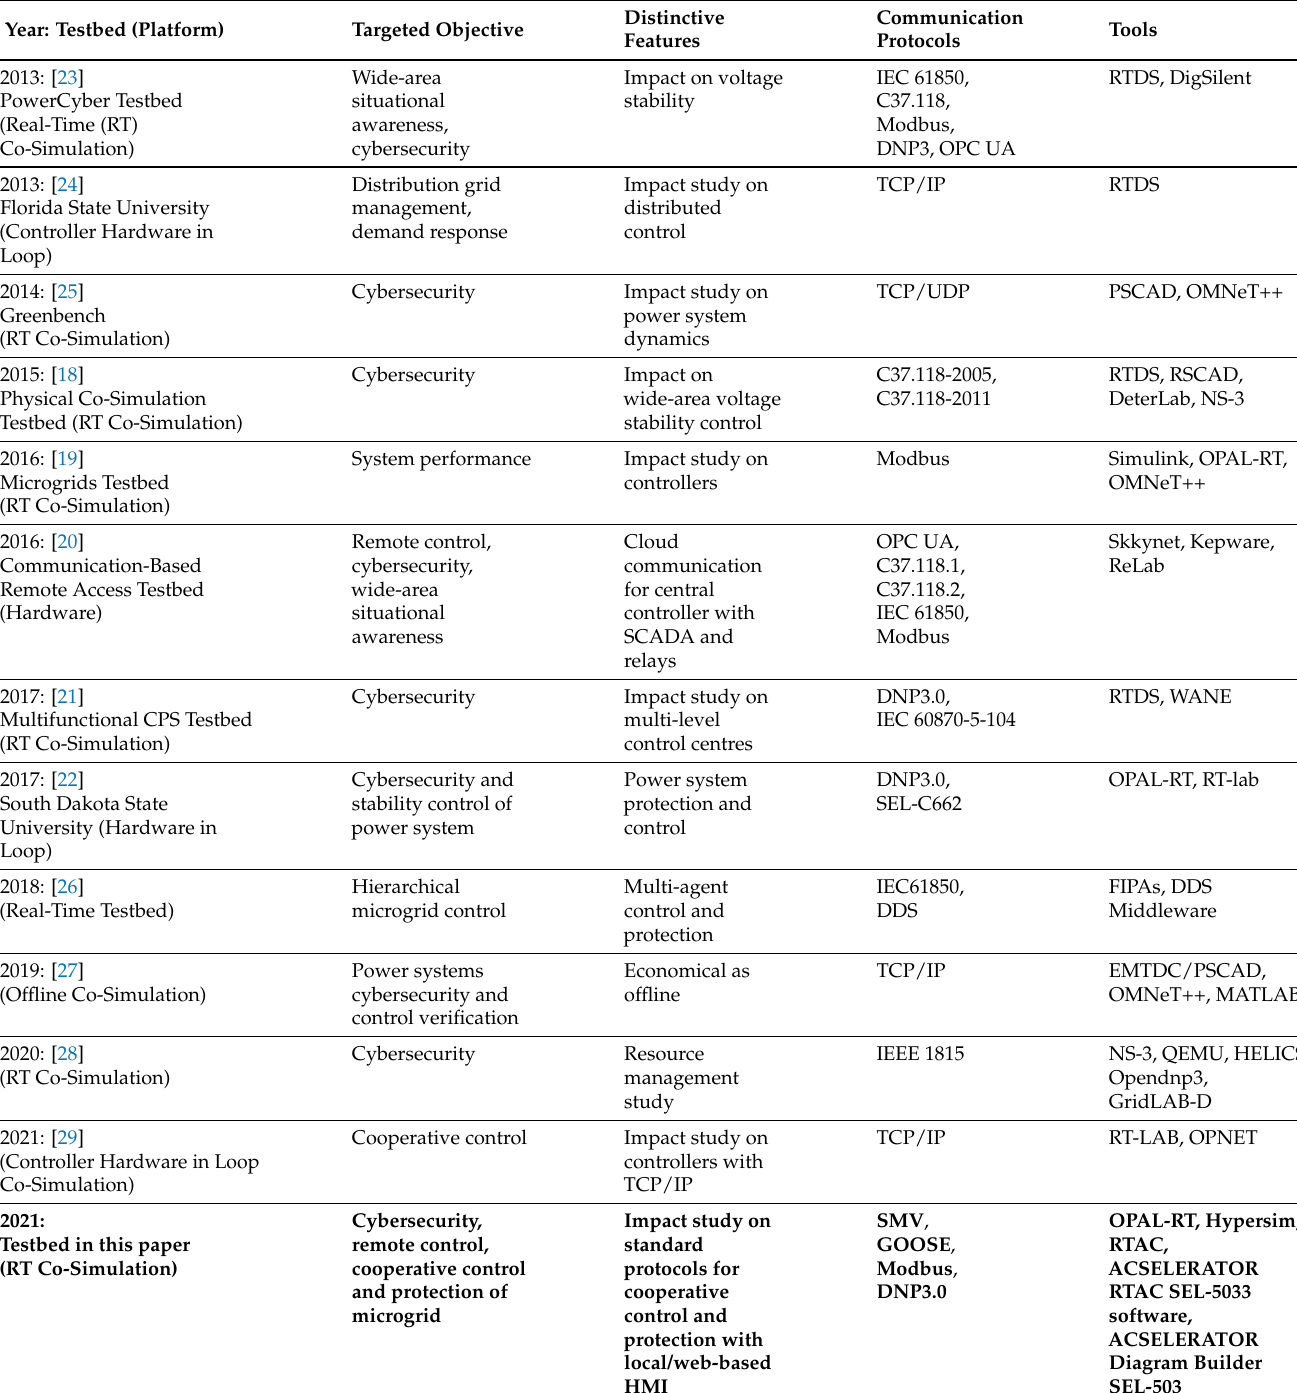
Table 1. Taxonomy of cyber-physical smart grid